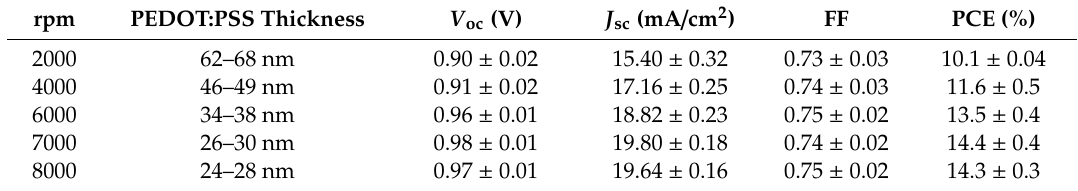
Table 1. Average device parameters of twelve PSCs based on di ff erent PEDOT:PSS coating conditions.